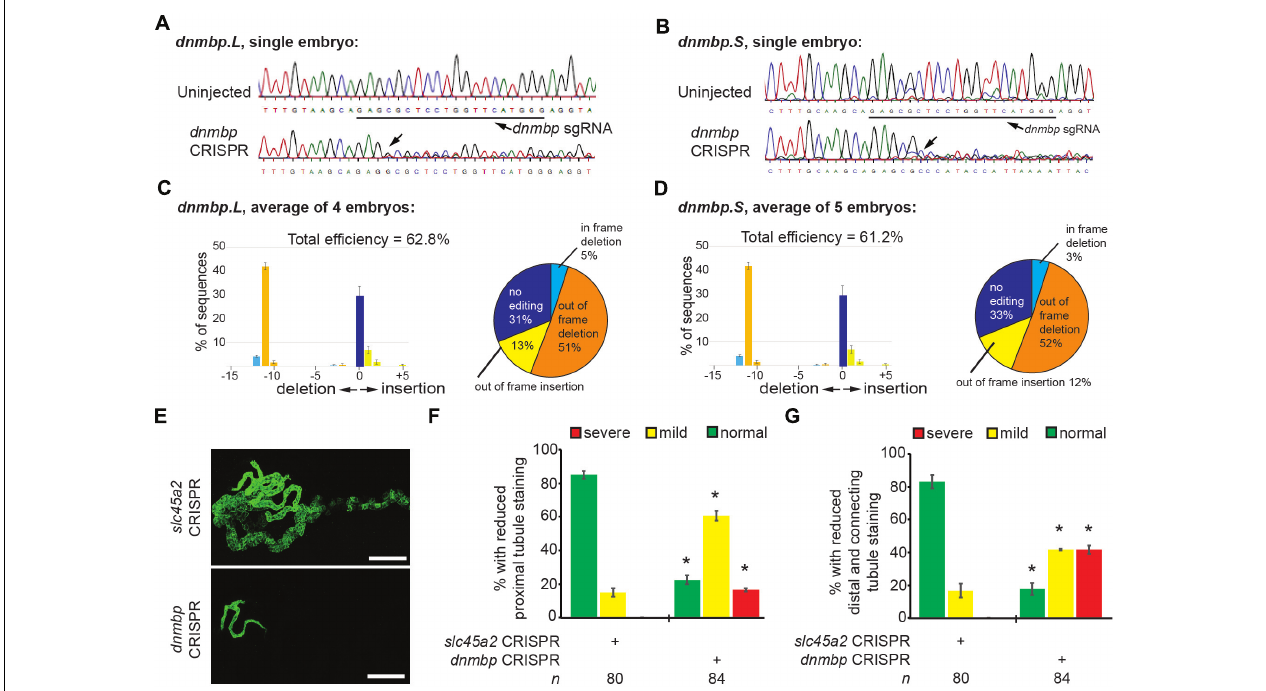
FIGURE 5 | sgRNA targeting dnmbp efficiently edits Xenopus embryo DNA. Stage 40 embryos injected with dnmbp sgRNA and Cas9 protein at the 1-cell stage. (A) Chromatogram showing CRISPR editing of dnmbp.L in a single embryo. The underlined sequence corresponds to the dnmbp sgRNA binding sequence, and the arrow indicates sequence degradation due to CRISPR. (B) Chromatogram showing CRISPR editing of dnmbp.S in a single embryo. The underlined sequence corresponds to the dnmbp sgRNA binding sequence, and the arrow indicates sequence degradation due to CRISPR. (C) TIDE analysis of dnmbp.L sequence trace degradation after the expected Cas9 cut site. ∗ p < 0.001. Percentage of dnmbp.L DNA sequence containing insertions and deletions. Bars indicate the mean of the percent of insertion/deletion sequences from four embryos, with the error bars representing the Standard error of the mean. Results are the mean of sequencing data from four embryos. (D) TIDE analysis of dnmbp.S sequence trace degradation after the expected Cas9 cut site. ∗ p < 0.001. Percentage of dnmbp.S DNA sequence containing insertions and deletions. Bars indicate the mean of the percent of insertion/deletion sequences from four embryos, with the error bars representing the Standard error of the mean. Results are the mean of sequencing data from four embryos. (E) Representative stage 40 embryos showing that 8-cell targeted knockout of dnmbp leads to disrupted kidney tubulogenesis in comparison to slc45a2 knockout controls. Antibody 3G8 labels the proximal tubule lumen and antibody 4A6 labels cell membranes of the distal and connecting tubules. White bar is 200 µ m. (F) Knockout of dnmbp reduces proximal tubule development. (G) Knockout of dnmbp reduces distal and intermediate tubule development. (F,G) n = number of embryos across 3 replications. Error bars represent Standard error. ∗ Significantly different from control, p <